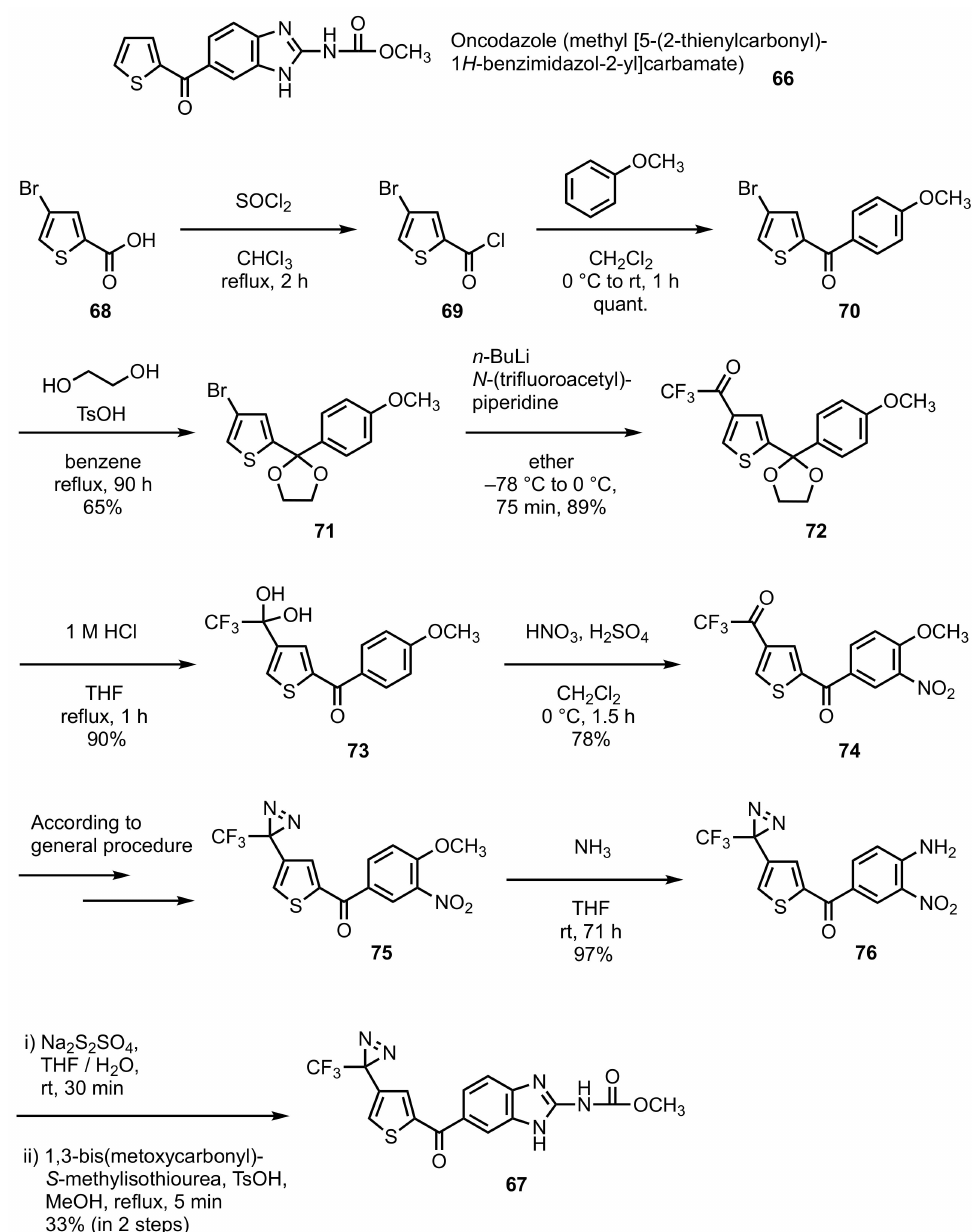
Scheme 10. The synthesis of diazirinyl-substituted thiophene analogue 67.